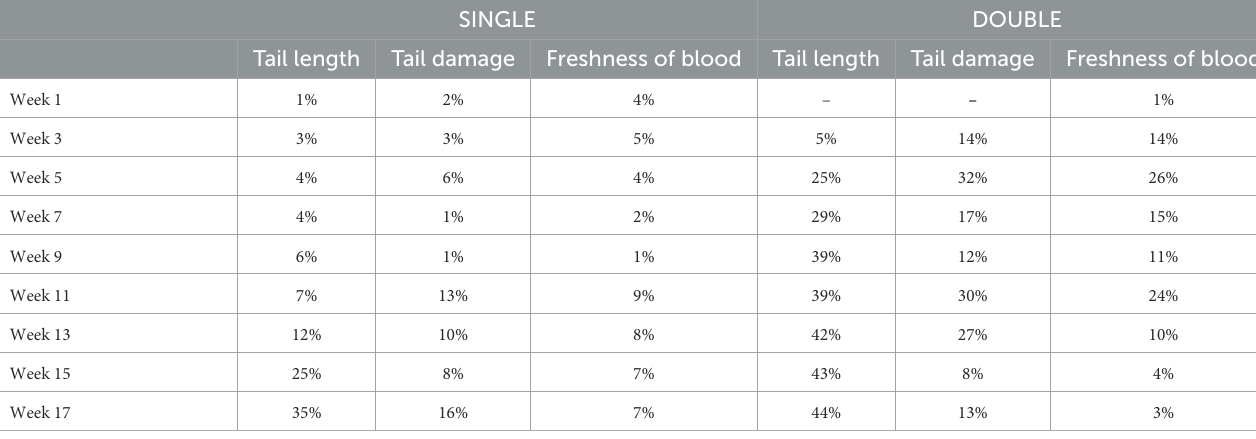
TABLE 4 Percentage of pigs in each treatment that had a score > 0 (perfect) for tail length, the freshness of blood, and damage of the skin of the tail, from the weaner stage to slaughter.